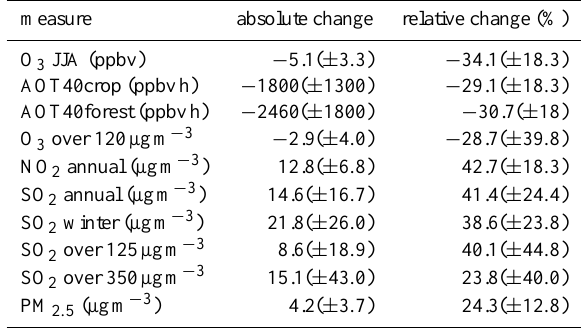
Table 5. The averaged maximal impact of urban emission on air quality (in terms of the quantities from Table 4) over cities. The 2nd and the 5th column stands for the absolute impact, the 3rd and the 6th column for the relative impact (for ozone related quantities) and contribution (for other species). The standard deviation of the all-city-average is included as